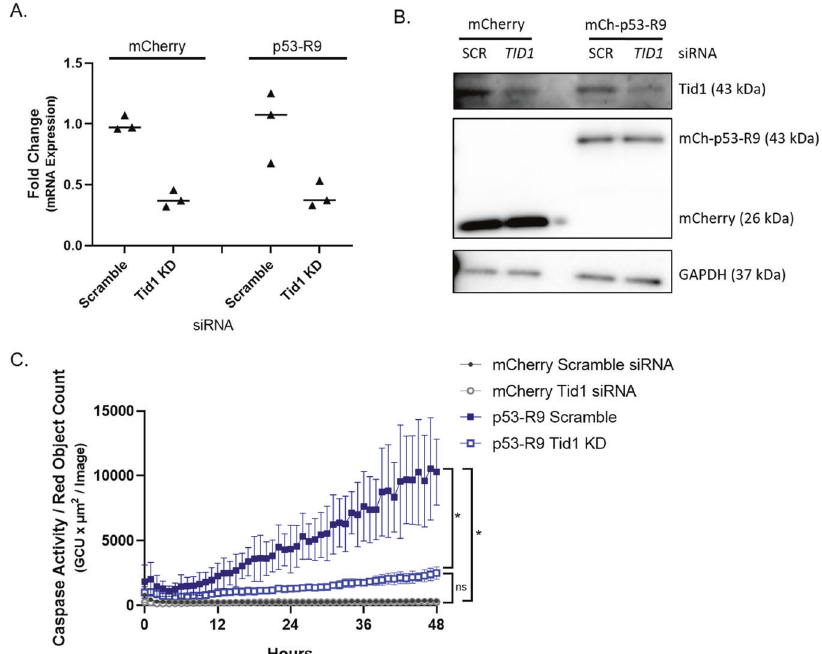
Fig. 7 Tid1 knockdown signi fi cantly decreases the ability of p53-R9 to induce apoptosis. A qPCR con fi rming Tid1 knockdown in mCherry and mCh-p53-R9 expressing U2OS TP53 − / − cells at the mRNA level. B Immunoblot con fi rming Tid1 knockdown in mCherry and mCh-p53-R9 U2OS TP53 − / − cells at the protein level. Blots were probed with antibodies to Tid1, mCherry, and GAPDH. C U2OS TP53 − / − cells expressing mCherry or mCh-p53-R9 were transfected with scramble or Tid1 siRNA and analyzed for Caspase-3/7 activity (Caspase-3/7 green apoptosis assay reagent used with the Incucyte Live-Cell Imaging and Analysis System). Area under the curve (AUC) was calculated for N = 3 experiments; Welch ’ s t test of AUCs from mCherry scramble siRNA versus mCh-p53-R9 scramble siRNA and mCh-p53-R9 scramble siRNA versus mCh-p53-R9 Tid1 siRNA, * p < 0.05. Welch ’ s t test of AUCs from mCherry Tid1 siRNA versus p53-R9 Tid1 siRNA, ns p > 0.05. Error bars represent standard deviation of three images/well taken in three wells of a representative